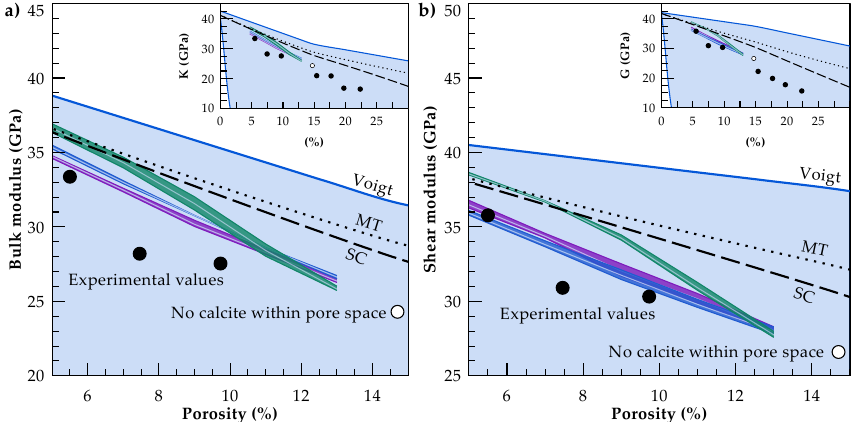
Figure 9. Simulations considering random (green), partially filled (blue) and coated (magenta) calcite distributions substantially reduce the overestimation produced by state-of-the-art analytical solutions as the Mori-Tanaka approach (MT, dotted line) and the self-consistent scheme (SC, dashed line). ( a ) Bulk and ( b ) shear moduli for the Fontainebleau sandstone determined in laboratory experiments [64] (black-filled circles), taking into account only the quartz component and void